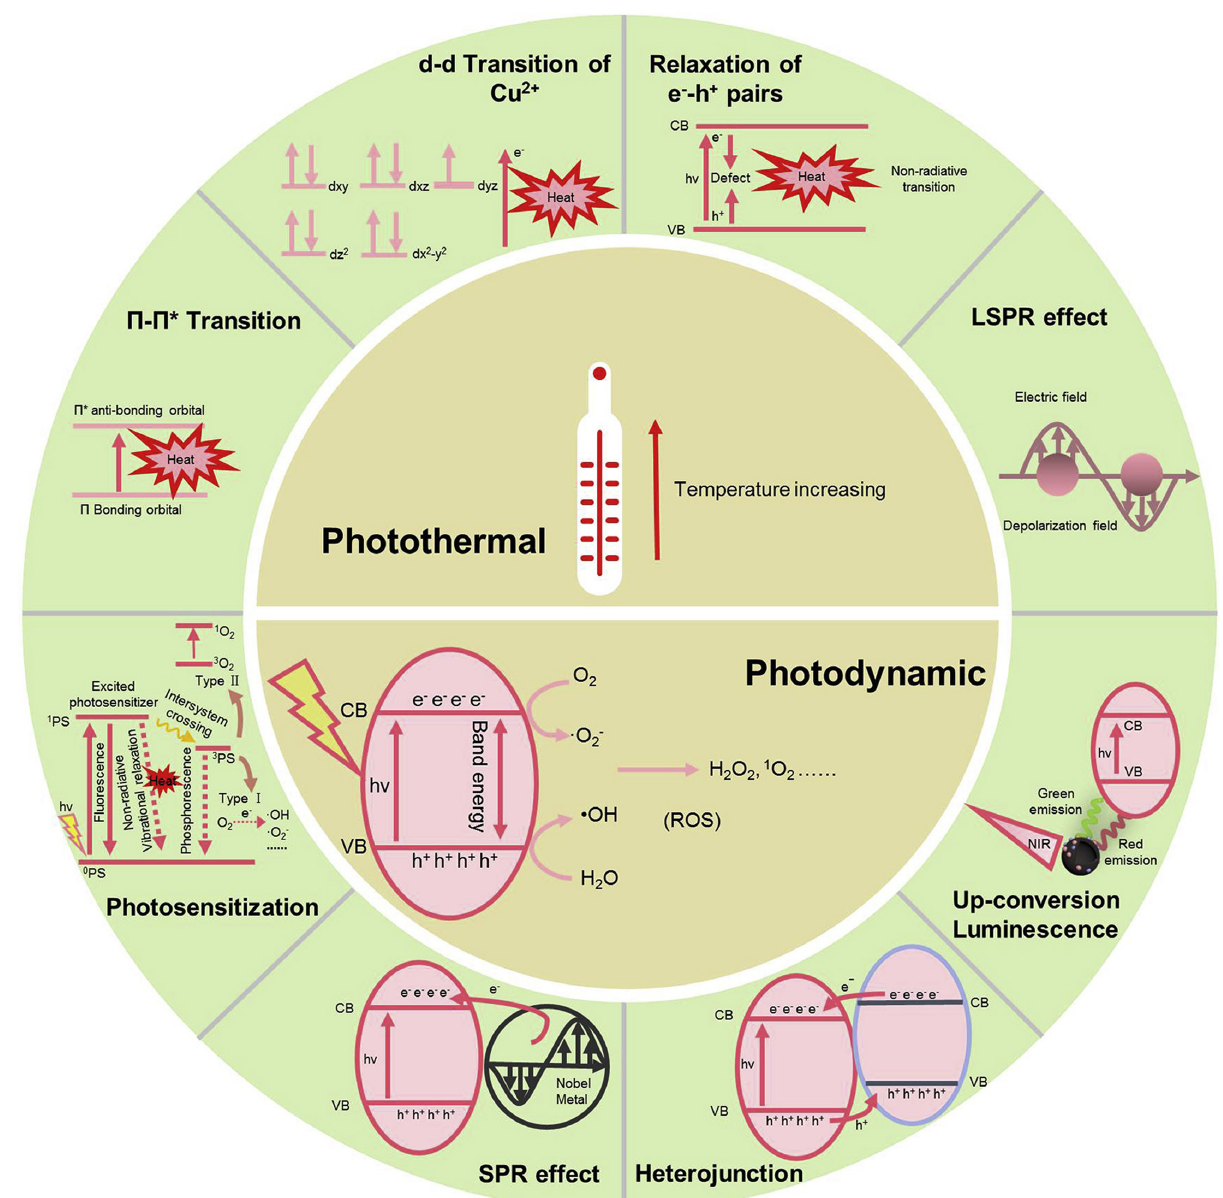
Figure 1. Mechanisms of photothermal therapy (PTT) and photodynamic therapy (PDT). Reproduced with permission from Ref. [12]. Copyright 2020 Elsevier. LSPR: localized surface plasmon resonance, SPR: surface plasmon resonance, CB: conduction band, VB: valence band.